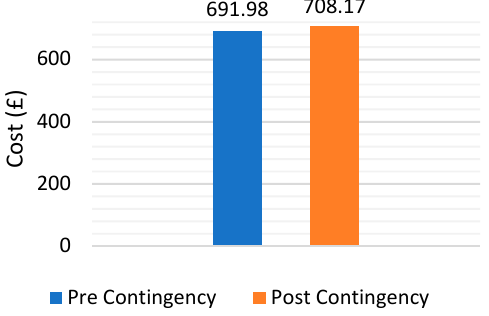
Figure 9. Scenario S3, year Y5: pre- and post-contingency network operating cost considering line L4 in contingency.